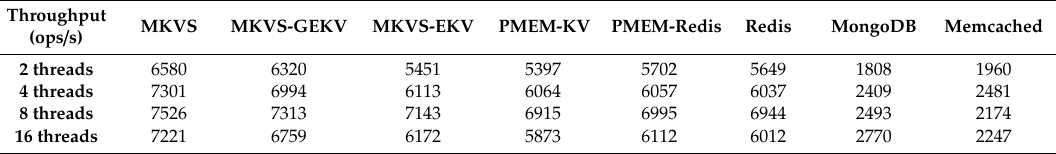
Table 2. The results of inserting KV pairs with